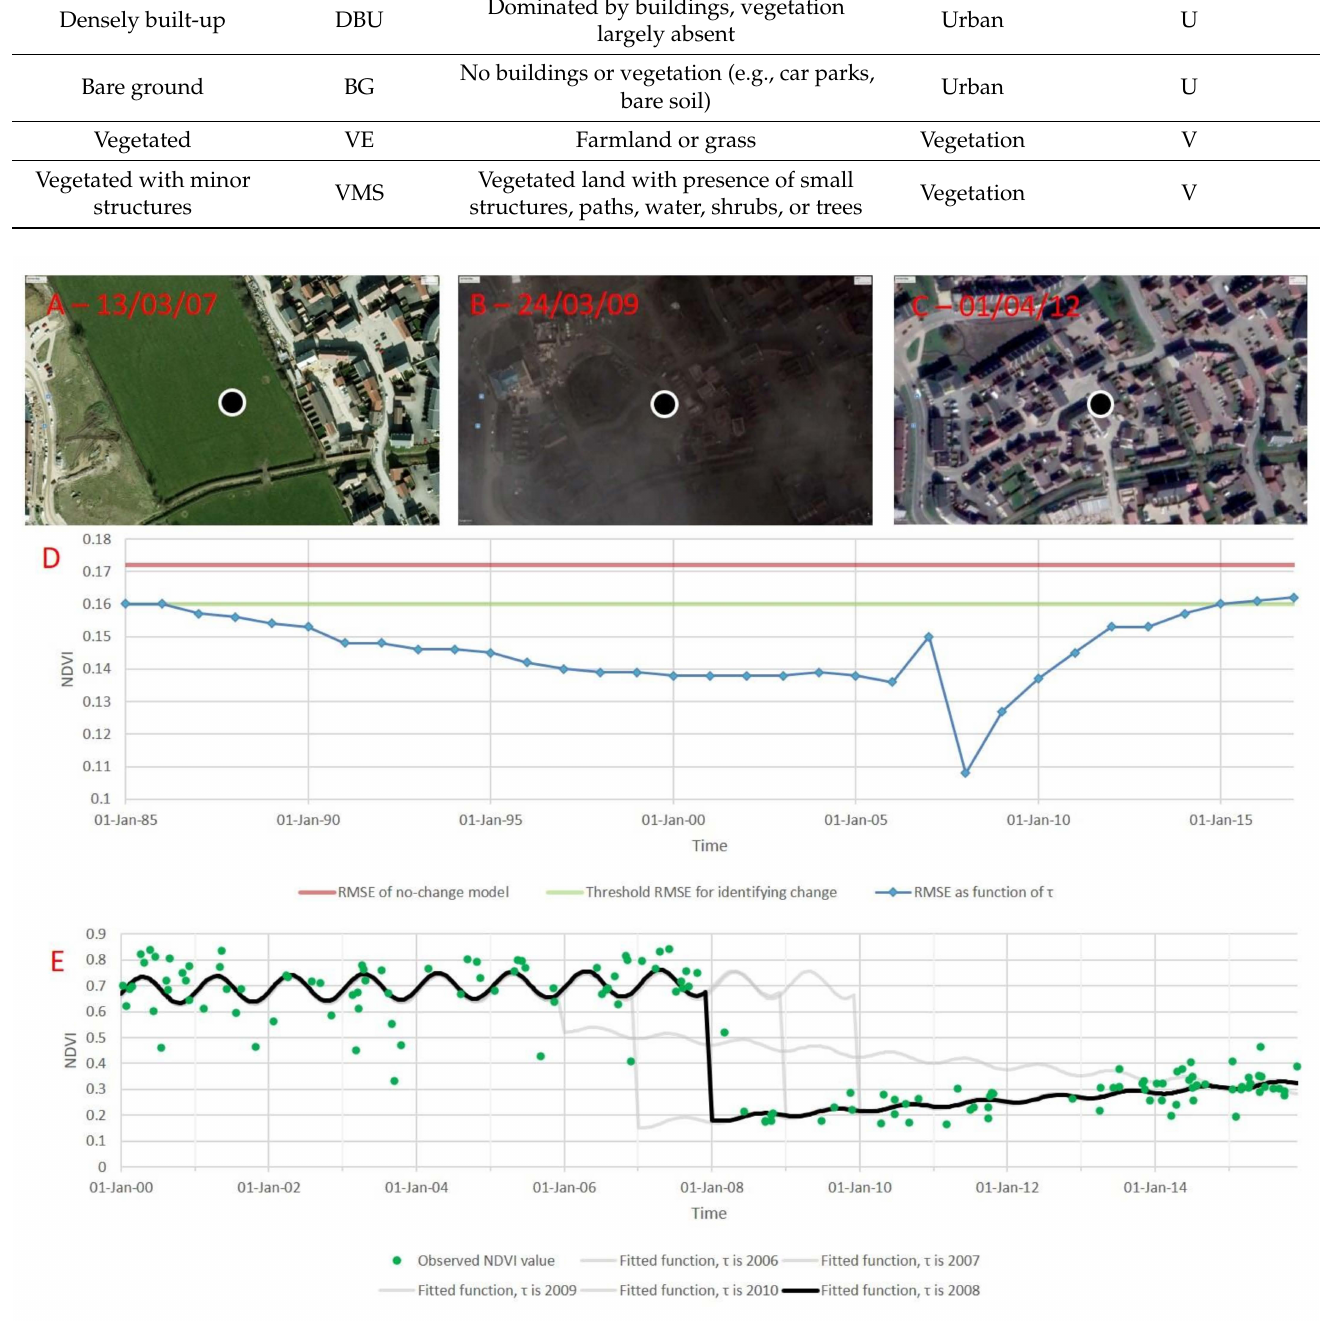
Figure 3. Illustration of method on a single pixel. ( A – C ) High-resolution images across the change occurrence, spot indicating centre of pixel. ( D ) Goodness-of-fit as function of assumed time-of-change, threshold is h = 0.93. ( E ): NDVI trend of observations, along with fitted functions. Black line corresponds to lowest RMSE, indicating the time-of-change. Set A will be used to detect change from 2003 to 2012, sets B, C, and D will detect change from 2006 to 2015. Finally set E will detect change from 2002 to 2015. Sets A and B were randomly selected from across Swindon and are therefore spatially balanced.